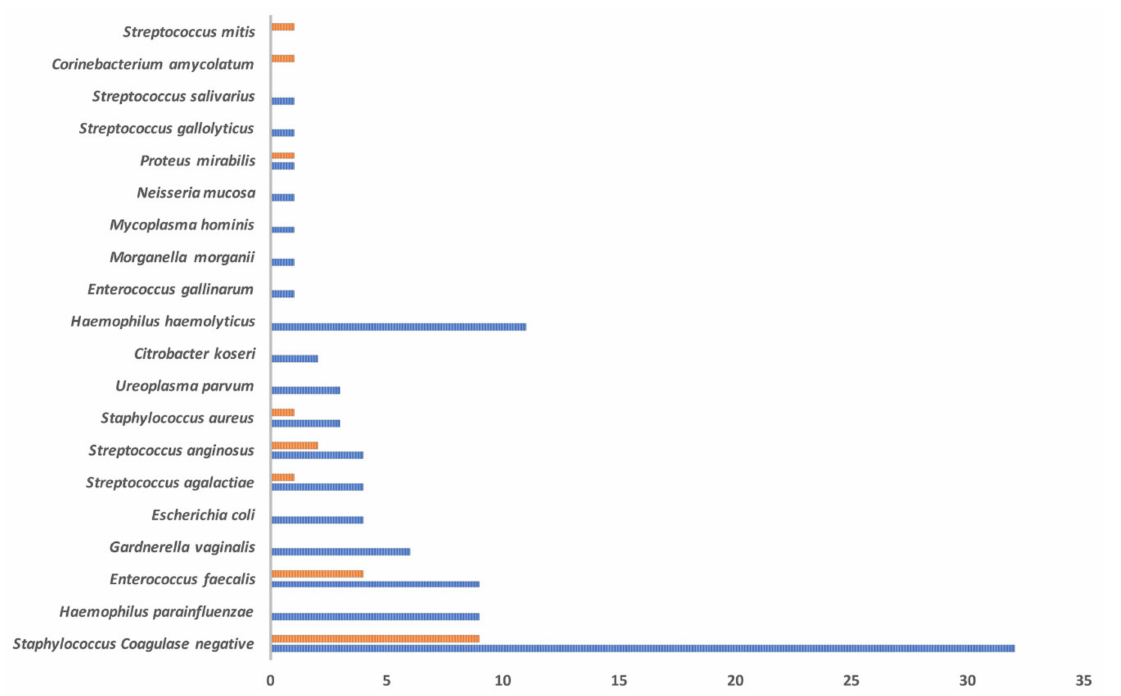
Figure 4. Microbiological evaluation of the collected semen samples among the Test (blue histogram; 37 samples) and the Control (orange histogram; 16 samples) groups. Histograms are used to report the number of samples positive for each microorganism.